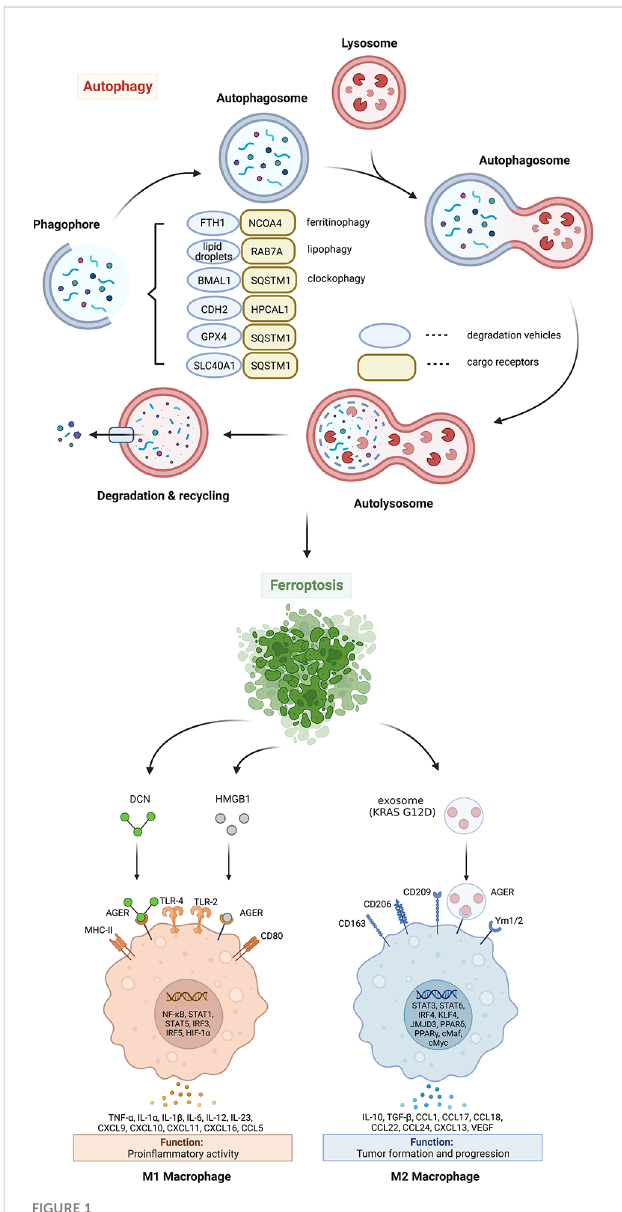
FIGURE 1 Mechanism and signi fi cance of autophagy-dependent ferroptosis. Autophagy promotes ferroptosis by selectively degrading anti- ferroptosis proteins or organelles through multiple autophagy receptors. DAMP release from ferroptotic cells can trigger in fl ammatory and immune responses in macrophages by activating the AGER pathway. AGER, advanced glycosylation end-product speci fi c receptor; BMAL1, brain and muscle ARNT-like 1; CDH2, cadherin 2; DCN, proteoglycan; FTH1, ferritin heavy chain 1; GPX4, glutathione peroxidase 4; HPCAL1, hippocalcin like 1; HMGB1, high mobility group box 1; IL, interleukin; MHC, major histocompatibility complex; NCOA4, nuclear receptor coactivator 4; RAB7A, member RAS oncogene family; SLC40A1, solute carrier family 40 member 1; SQSTM1, sequestosome 1; TLR, toll-like receptor; TNF, tumor necrosis factor; VEGF, vascular endothelial growth